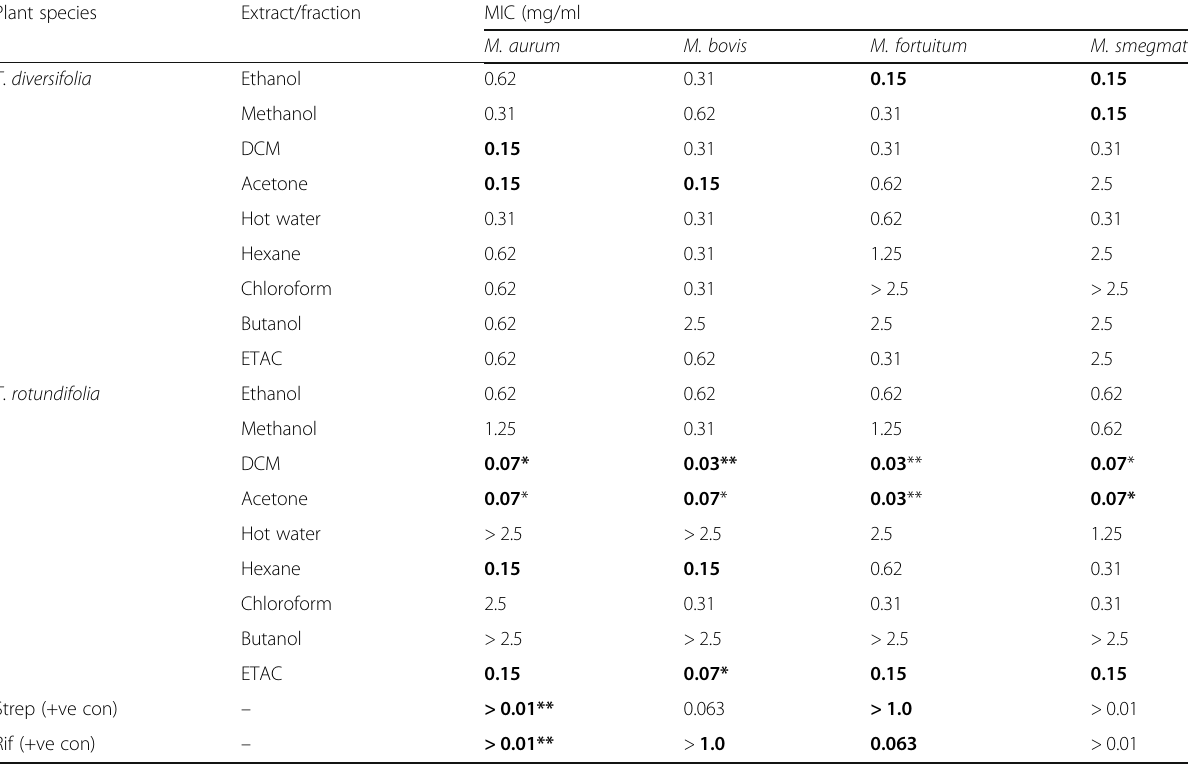
Table 2 Antimycobacterial activity of solvent extracts and fractions of T. diversifolia and T. rotundifolia Plant